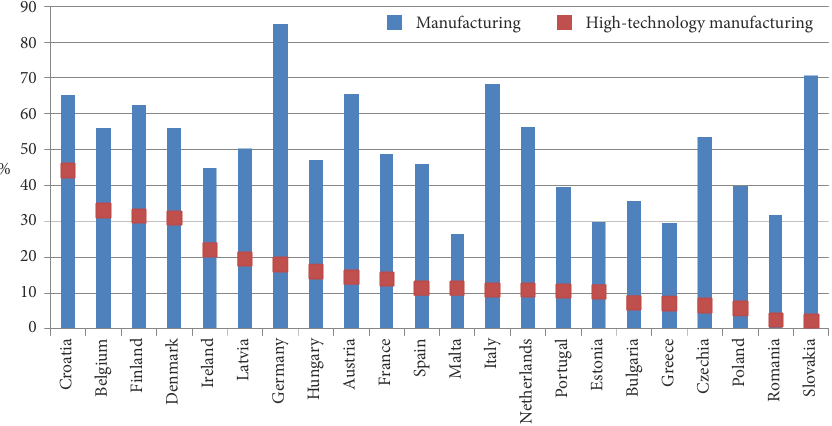
Figure 6. Business enterprise R&D expenditure in manufacturing and in high-tech manufacturing (as % of total R&D expenditure), 2017 (source: author computation based on Eurostat,